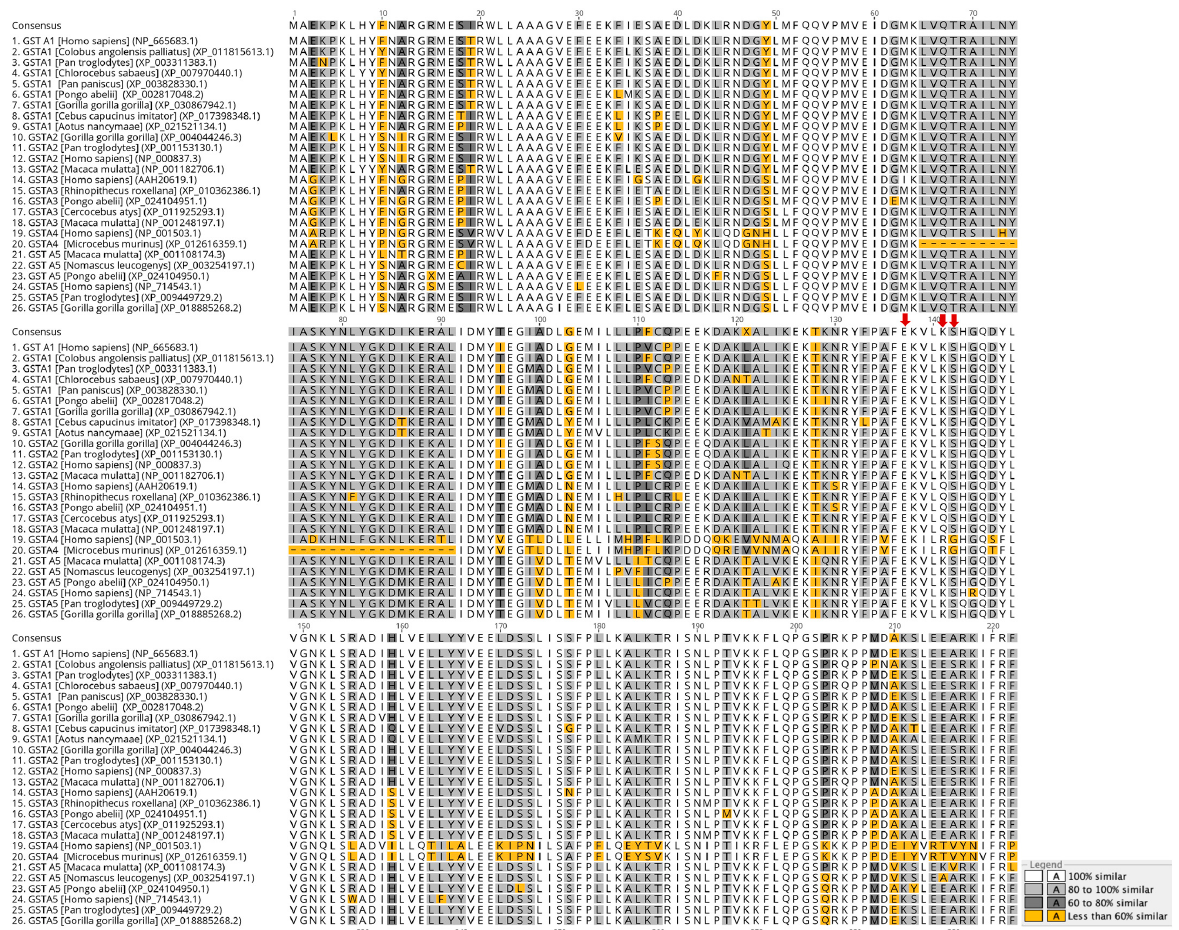
Figure 1. Multiple amino acid sequence alignment of alpha class GSTs colored according to similarity. Red arrows depict the amino acids of the helix H5 motif that were selected in the present study. The figure was created using the Geneious v9.1.2 [29].